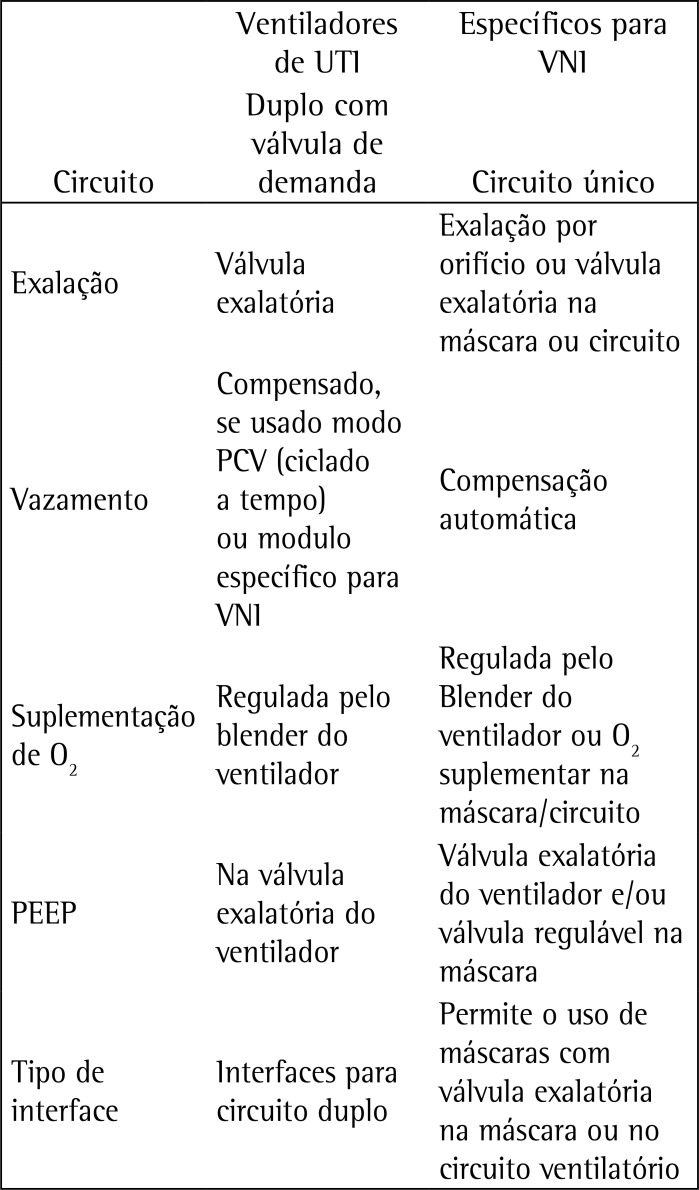
Diferenças entre a ventilação não invasiva administrada pelos
ventiladores portáteis específicos para ventilação não invasiva e dos
ventiladores de unidade de terapia intensiva microprocessados com módulo
de ventilação não invasiva UTI - unidade de terapia intensiva; PCV -
ventilação controlada a pressão; VNI - ventilação não invasiva; O2 -
oxigênio; PEEP - pressão expiratória final positiva.